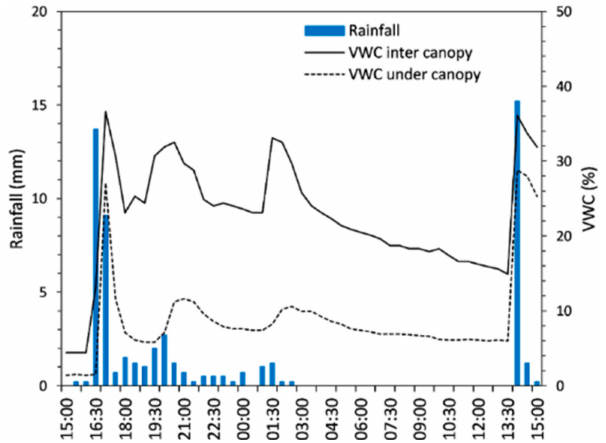
Figure 10. Soil moisture behavior inter canopy and under canopy for one rainfall event (37 mm) on 4 July 2019, in micro-catchment